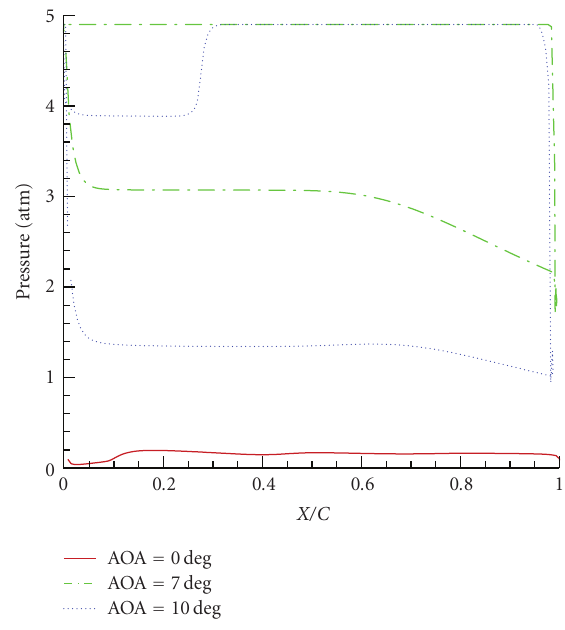
Figure 7: Pressure profile of HTPB surface at di ff erent AOA (C: length of the HTPB